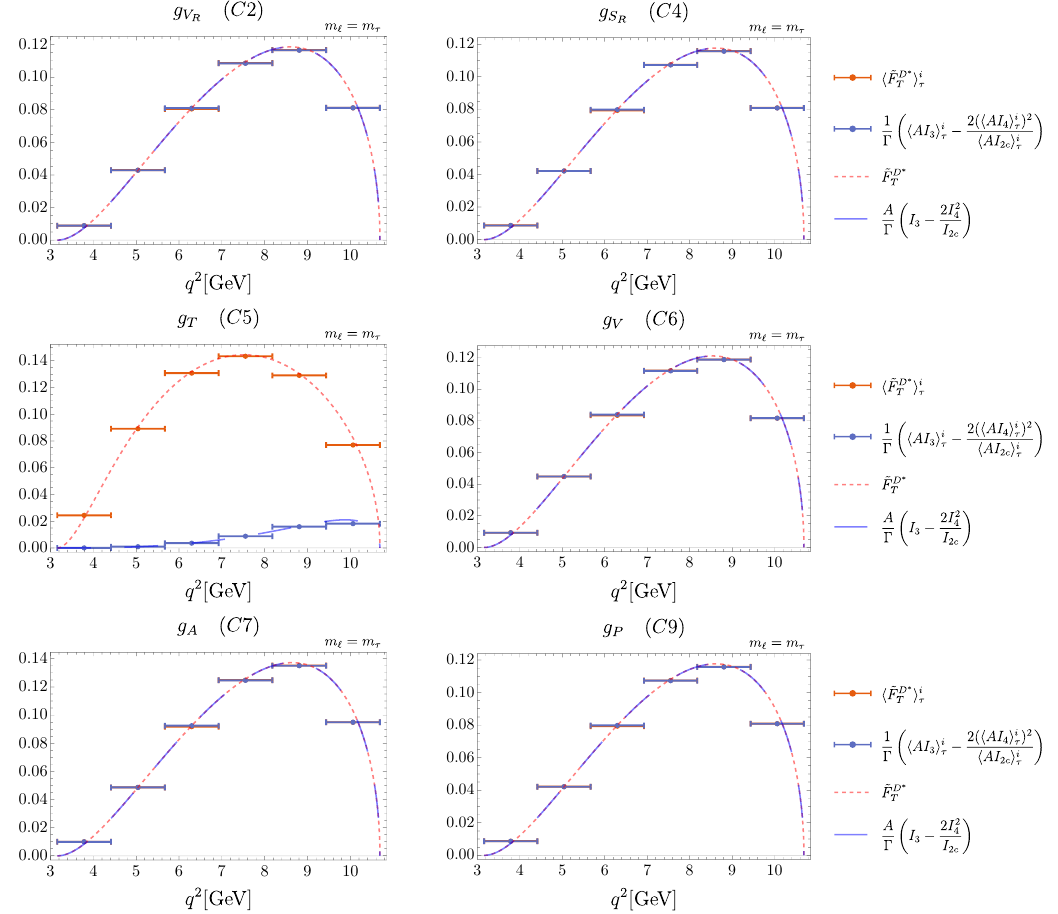
Figure 7. Study of binning e(cid:11)ects for eq. (4.19) for benchmark NP scenarios with complex con- tributions.